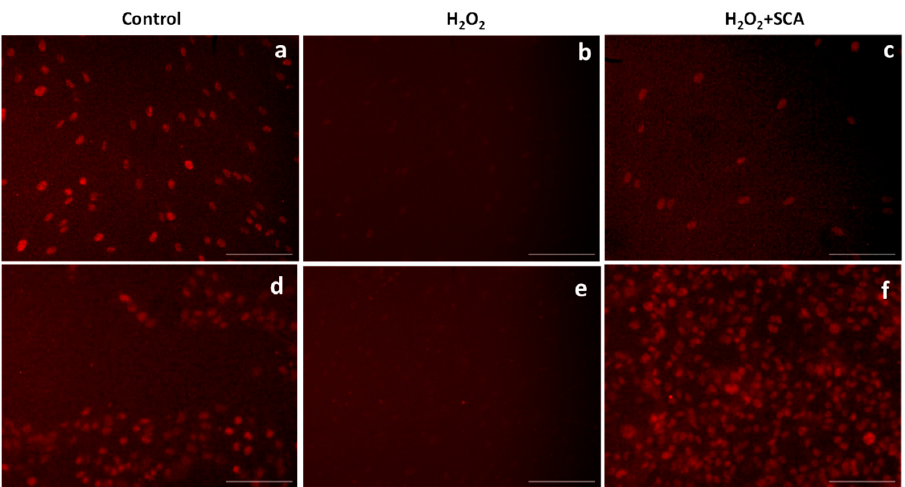
Figure 5. Treatment with SCA ® markedly induced SIRT1 expression in senescent cells. Representa- tive fluorescence microscopy images after SIRT1 (red) immunostaining. Cells treated with H 2 O 2 ( b , e ) showed decreased expression of SIRT1. Fibroblasts ( a – c ) and B16-F10 cells ( d – f ) were exposed to H 2 O 2 and treated with SCA ® ( c , f ). Scale bars: 200 µm.